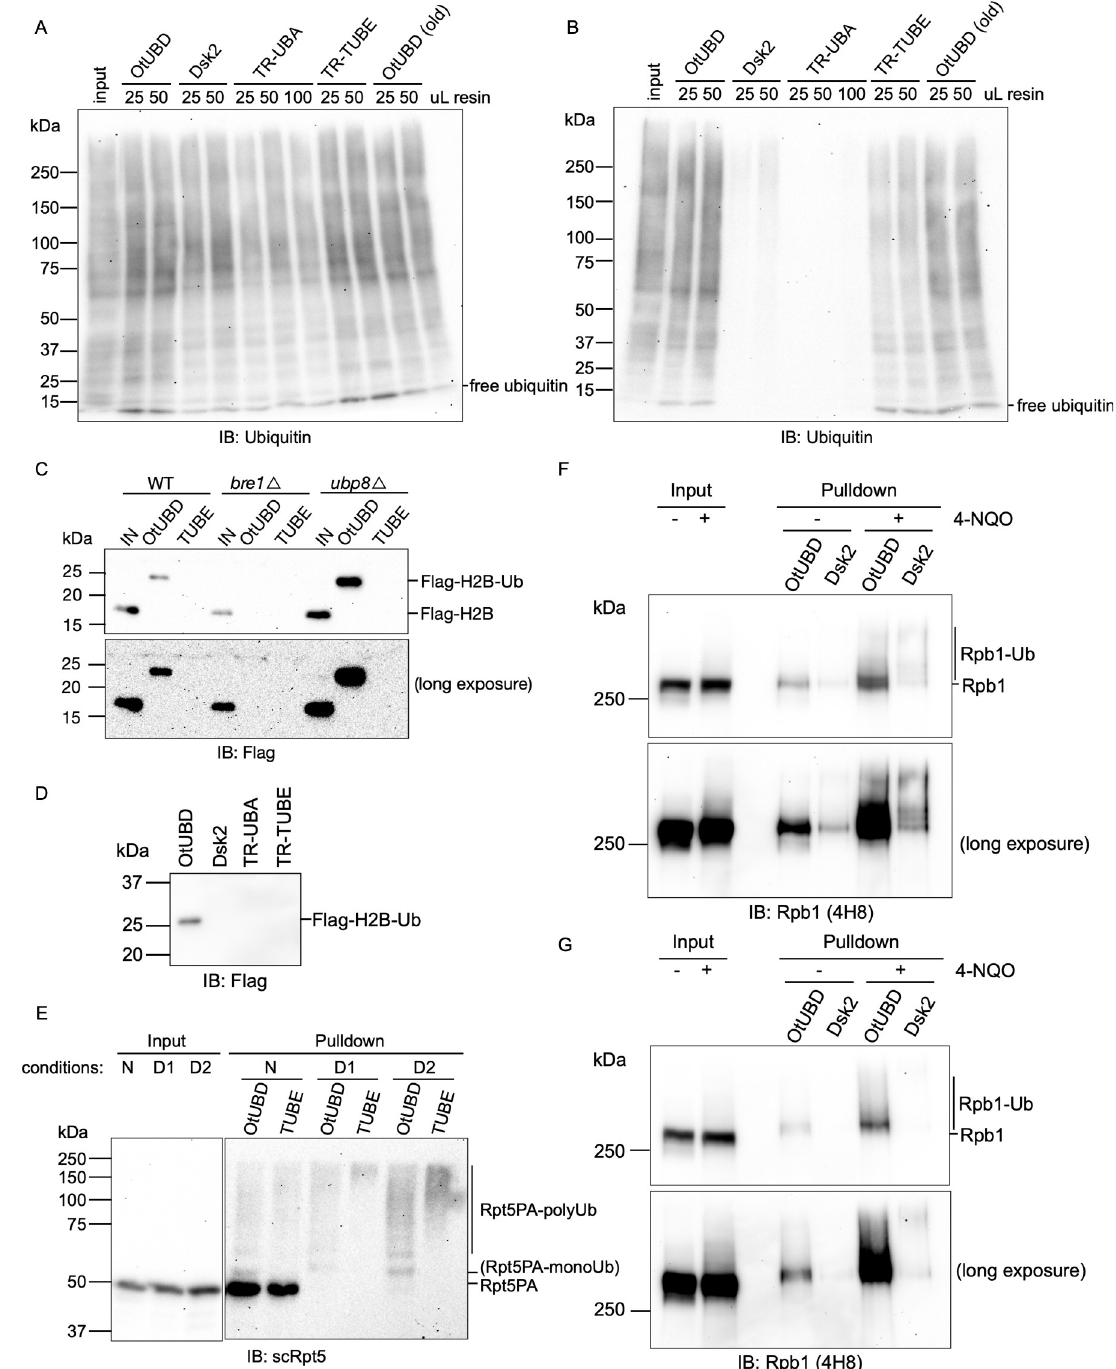
Fig 4. Comparison of OtUBD with other ubiquitin enriching reagents. (A) Anti-ubiquitin immunoblot of ubiquitin pulldowns from yeast whole cell lysate using different UBD/TUBE-based reagents under native conditions. Yeast whole cell lysate with 1mg of total protein was used in each pulldown. Elution was achieved by incubating resins with SDS sample buffer. (B) Anti-ubiquitin immunoblot of ubiquitin pulldowns from yeast whole cell lysate using different UBD/TUBE-based reagents following lysate denaturation. Yeast whole cell lysate with 1 mg of total protein was used in each pulldown. Elution was achieved by incubating resins with SDS sample buffer. (C) Anti-Flag immunoblot of OtUBD and TUBE pulldowns from lysates of WT, bre1 Δ and ubp8 Δ yeasts expressing Flag-tagged histone H2B. OtUBD resin but not TUBE bound monoubiquitylated histone H2B from whole cell lysate of WT and ubp8 Δ yeasts. IN, input; UBD, eluted fraction from OtUBD pulldown; TUBE, eluted fraction from TUBE pulldown. Elution was achieved by incubating resins with SDS